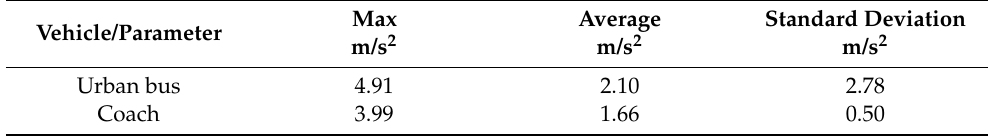
Table 7. Statistical characteristics of acceleration values collected in regular driving conditions of the analyzed vehicles during acceleration